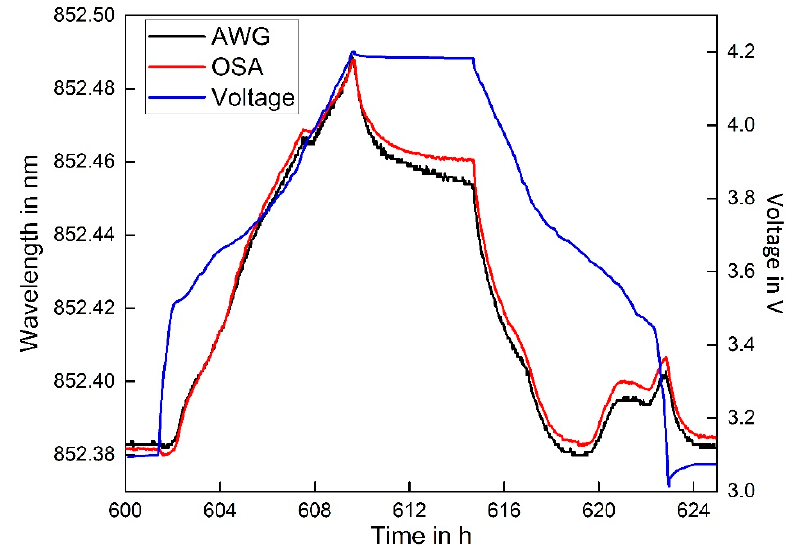
Figure 9. Exemplary single cycle showing the typical optically measured strain behavior of a lithium-ion cell along with the cell voltage.